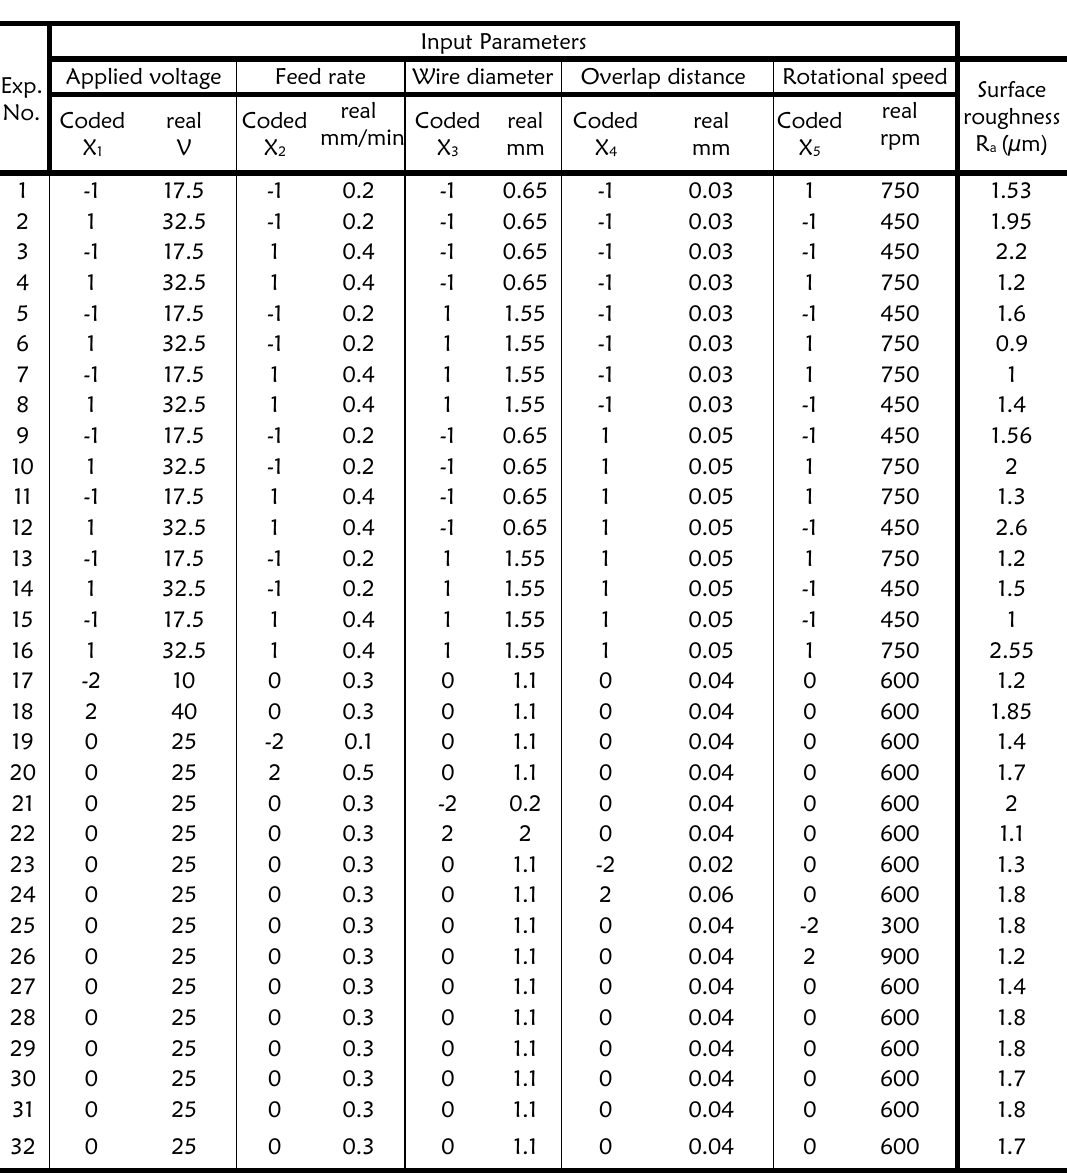
Table 3: Matrix of input variables and corresponding responses